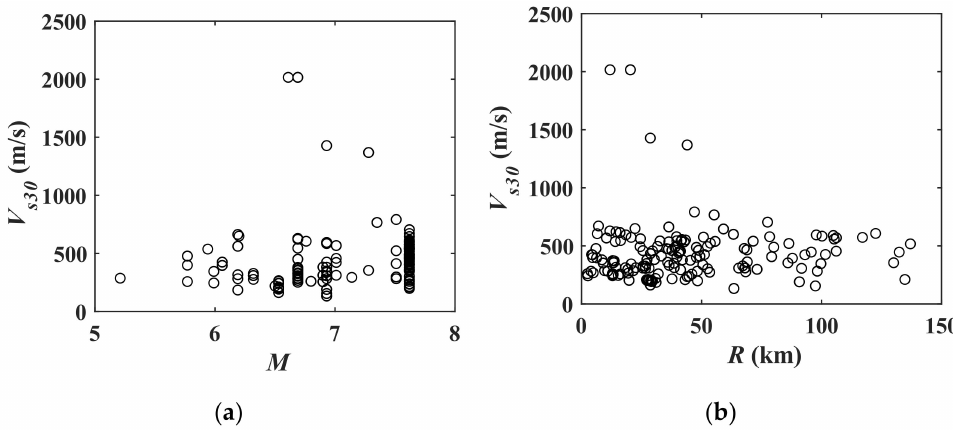
Figure 4. Distribution ranges of M , R , and V s30 of the selected pulse-like ground motions. ( a ) V s 30-M; ( b ) V s 30-R